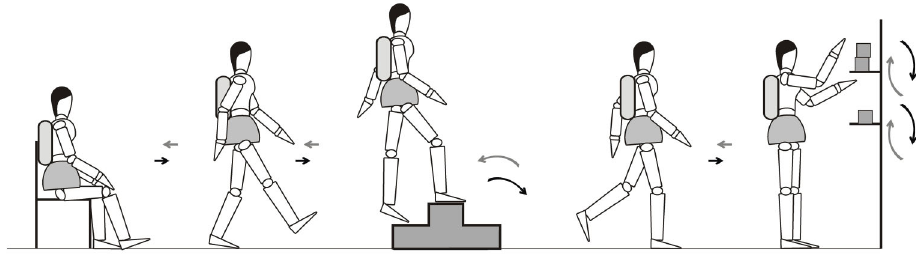
Figure 1. The Glittre activities of daily living test with multiple